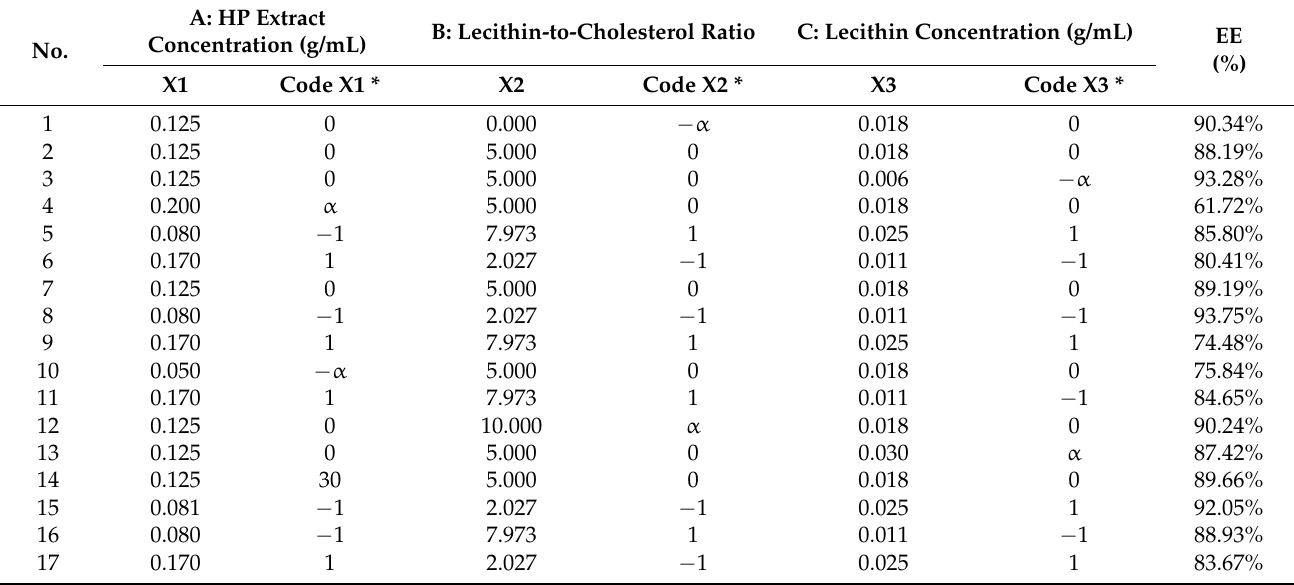
Table 1. Central Composite Design Matrix and The Response Values for The EE of Betacyanin in HPBL.